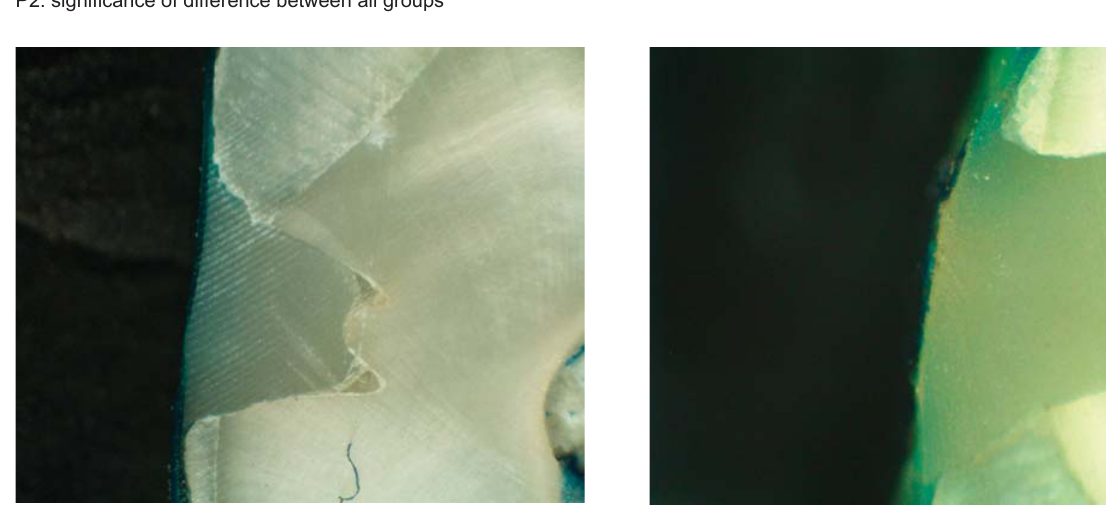
Figure 2- Photomicrograph of control group (laser) showing no micro leakage (score 0)